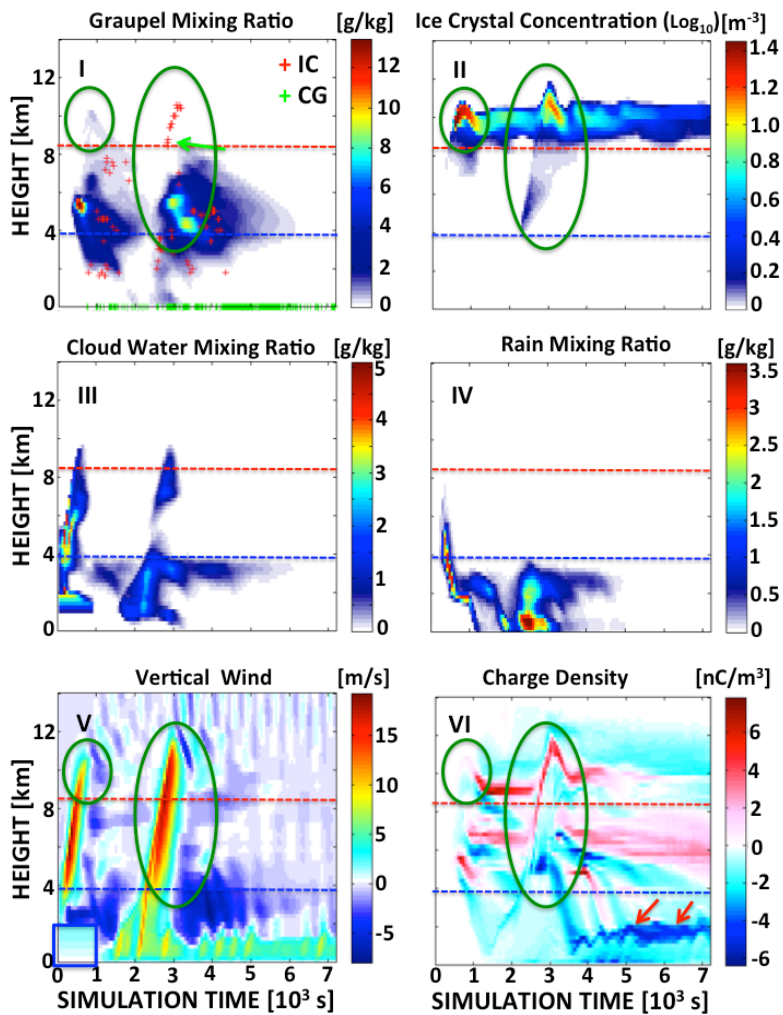
Fig. 13. Same as for Fig. 12, but for Case 2 (Rome, 2 July 2009). The green circles evidence the presence of growing ice crystals and high Figure 13 1 concentration of ice crystals at high levels associated and high positive charge density. The red arrows in panel (VI) indicate high negative charge density at low levels. The green arrow in panel (I) indicates a very high initiation height of IC’s. The blue rectangle evidences the cloud initiation phase, where, besides the thermal perturbation, a constant vertical wind at cloud base has been applied to simulate orographic